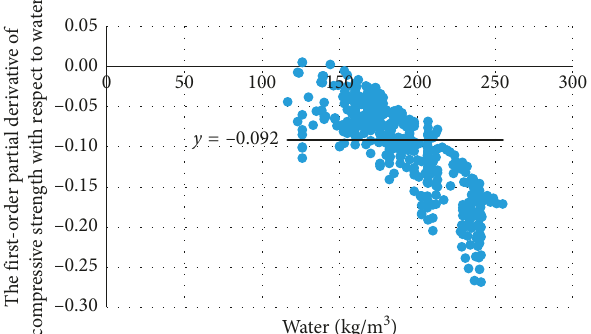
Figure 6: Distribution of water and the first-order partial de- rivative of compressive strength with respect to water for the training samples of the CSPNN.